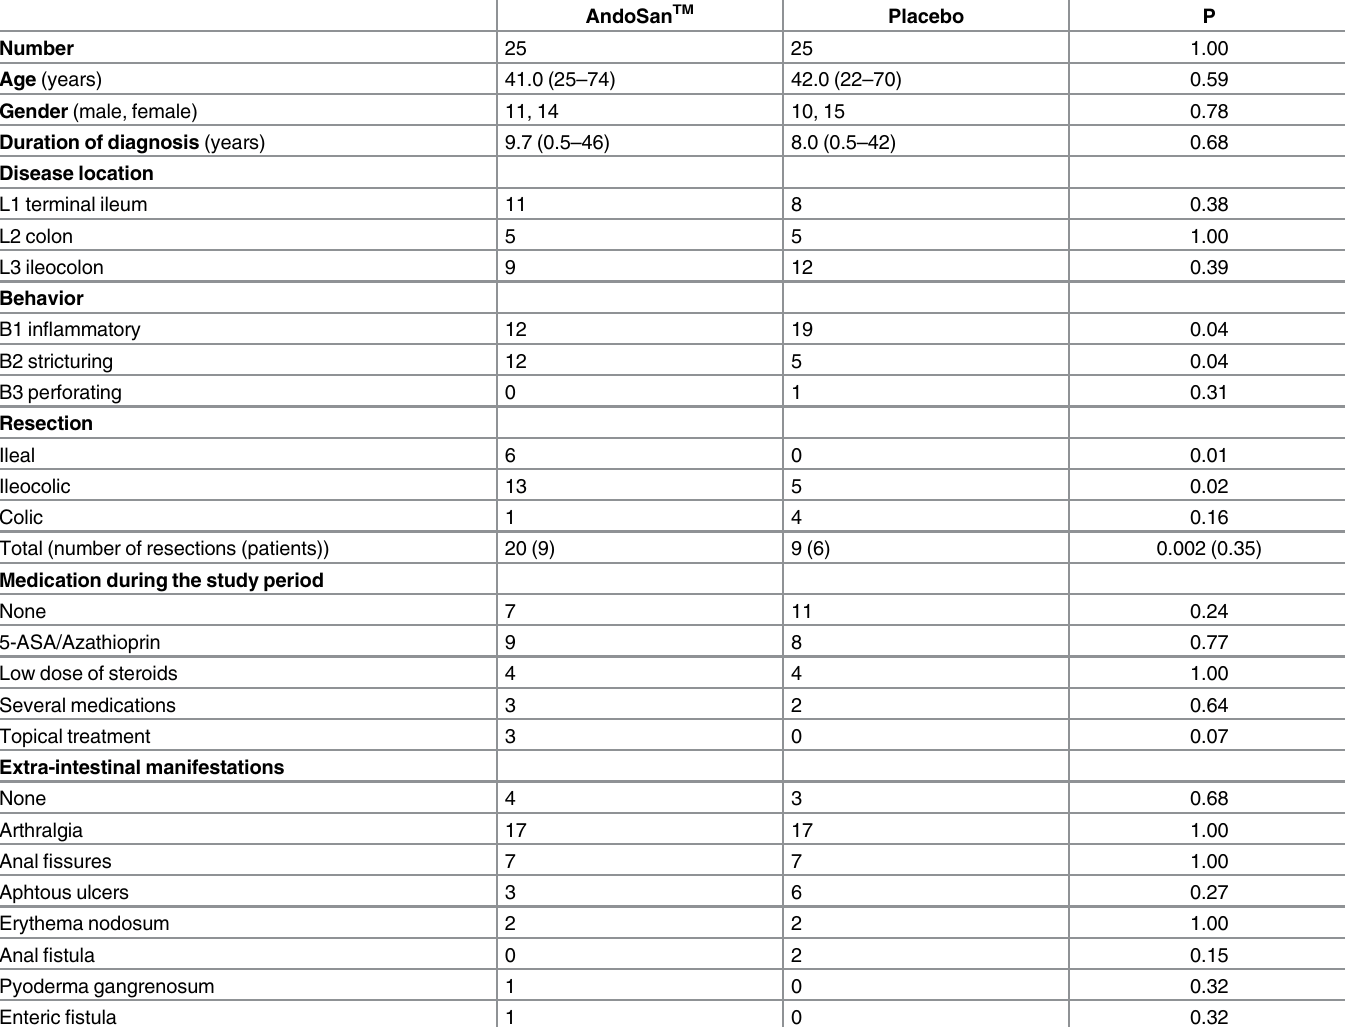
Table 1. Demographic and patient data.